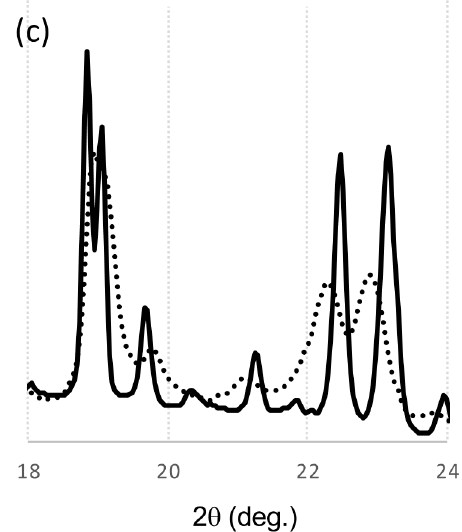
Figure 6. SR-XRD patterns from LLL crystals in α route. ( a ) Time evolution on small- and wide-angles X-ray scattering (SAXS and WAXS). The temperature change during the measurement is in the right. Di ff raction intensity is shown in rainbow colors from violet to red. ( b ) SAXS and WAXS profile changes from di ff erent polymorphs. The triangles in ( a ) indicate the time of each profile. ( c ) Comparison of WAXS profiles of β 3 α and β 4 α at 20 ◦ C. The solid and dotted lines are for β 3 α and β 4 α , respectively.